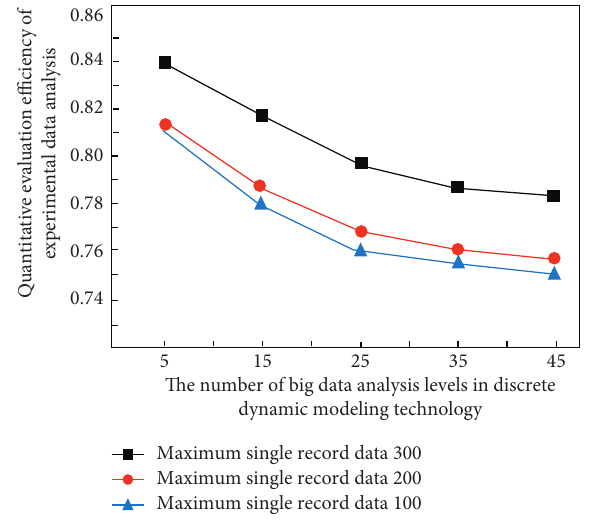
Figure 8: Experimental analysis results of depth recursive pro- cessing of different levels of data